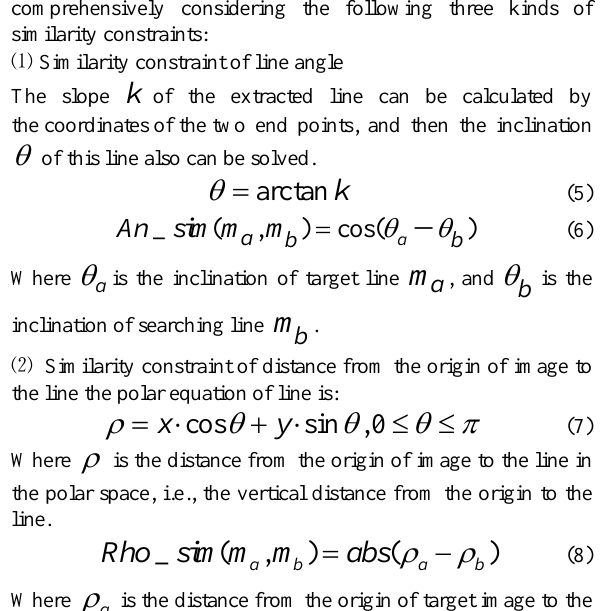
supporting region. As shown in Figure 4 (a), L is a straight line segment which length is n in the discrete image